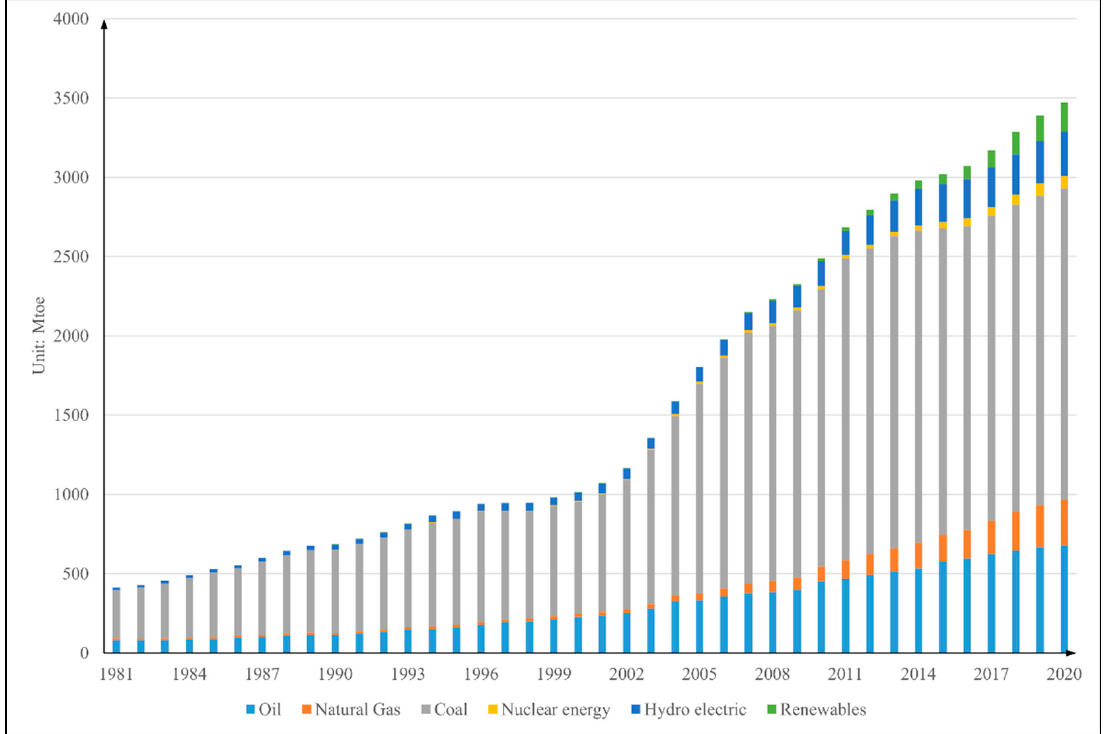
Figure 1. Energy consumption from 1981 to 2020 in China.